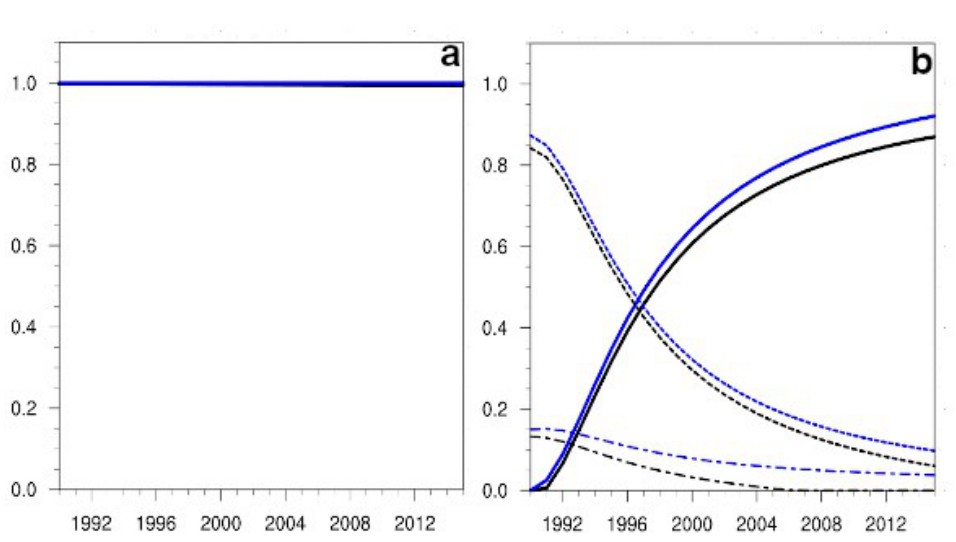
Figure 4. ( a ) Projection in time from the 1990 initial conditions of the Sobol sensitivity indices, first order S i (represented with black lines) and total S T (depicted with blue lines), for the variable i passengers, in the case of National flights (S). Line styles are the same as in Figure 3a. ( b ) The evolution in time of the Sobol indices, first order and total, for the variable emissions. The sensitivities to the β parameter term are depicted with solid lines, those to the a 22 term with short dashed lines, and the ones to the a 12 term with short and long dashed lines.